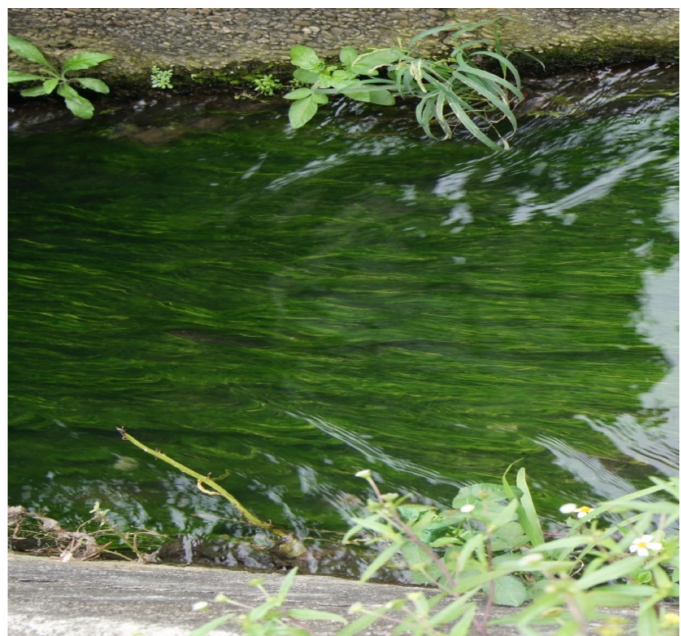
Figure 1. Water weeds topple due to flow.